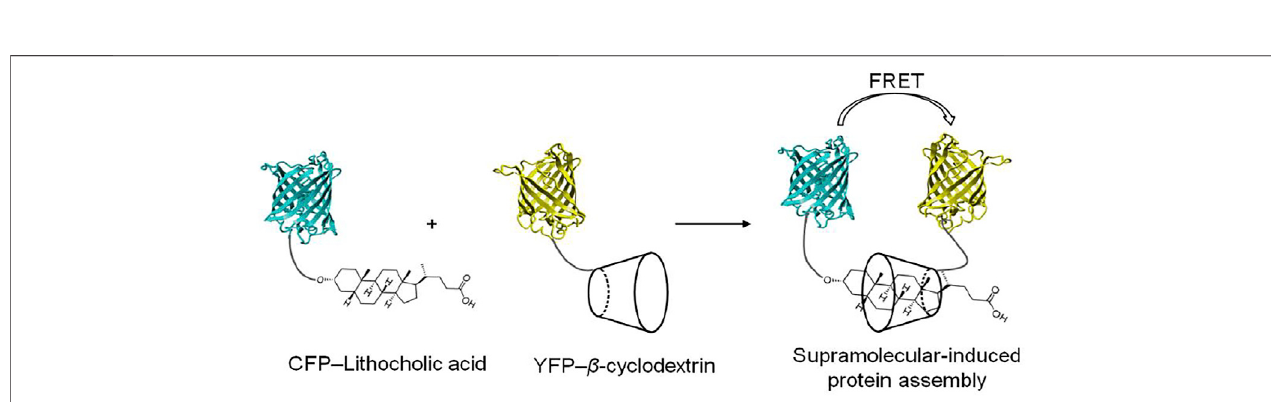
FIGURE 6 | Schematic representation of cyclodextrin-induced assembly of CFP and YFP functionalized with lithocholic acid and cyclodextrin, respectively (Zhang et al., 2007).